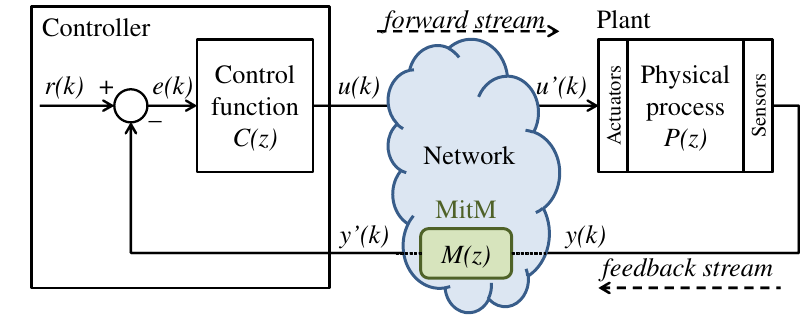
Figure 2. SD-controlled data injection